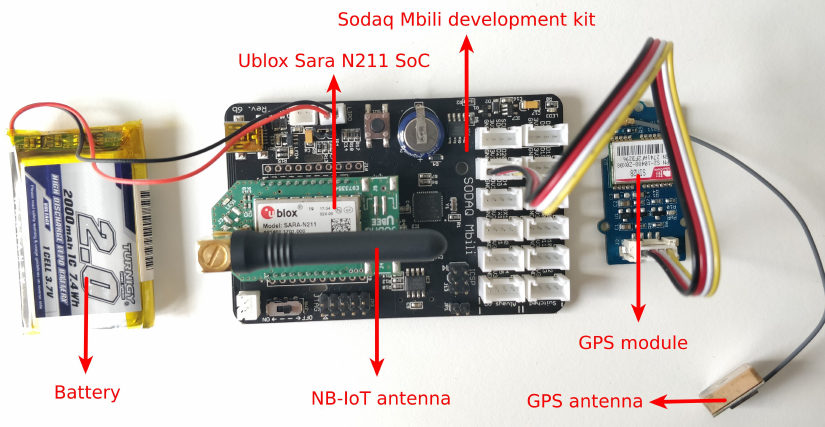
Figure 1. Composition of the User Equipment (UE) used to collect NB-IoT